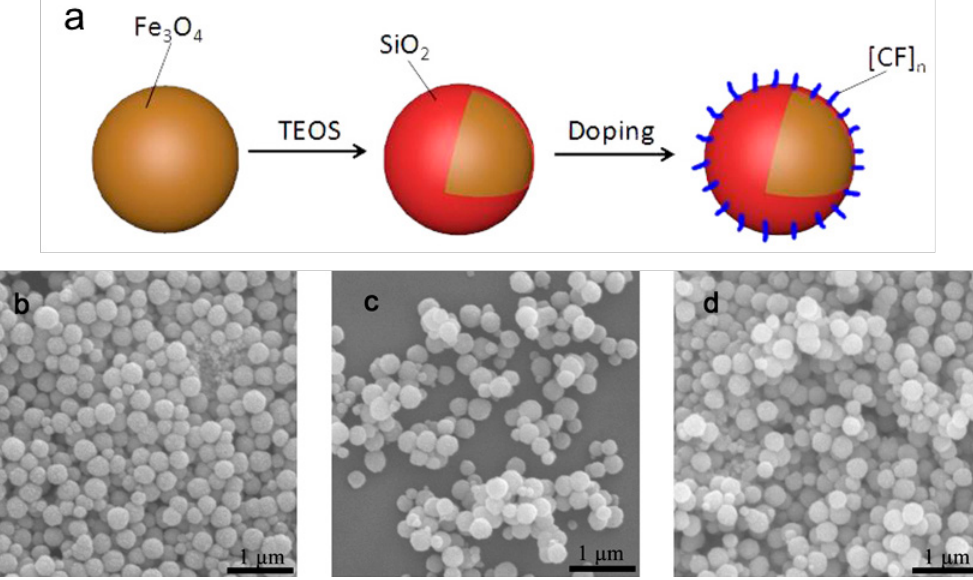
Figure 1. ( a ) Schematic illustration of the preparation hydrophobic magnetic nanoparticles and scanning electron microscopy (SEM) images of ( b ) the original magnetic nanoparticles; ( c ) after silica growth and ( d ) further modification with fluorosilane.